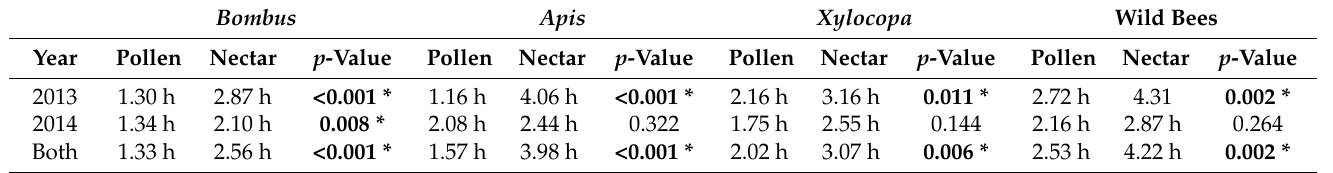
Table 4. Foraging activity of bumblebees vs. each of the other three categories as a function of time after sunrise. On Pollen Flowers On Nectar Flowers p -Value of Bombus Versus: p -Value of Bombus Versus: Year Apis Xylocopa Wild Bees Apis Xylocopa Wild Bees